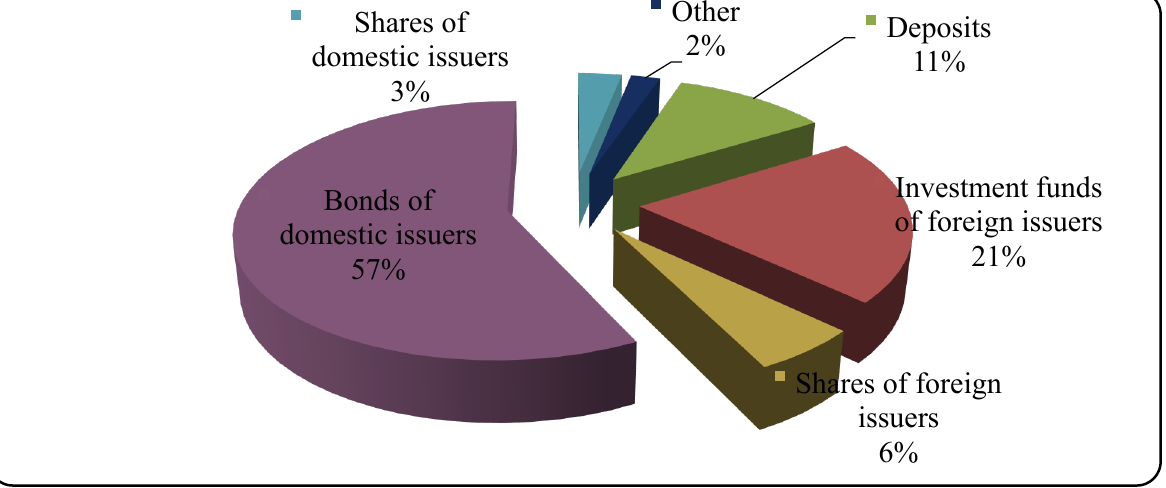
Figure 3: Investment tools used by the private pension funds and their rates 31.12.2018; Source: MAPAS,